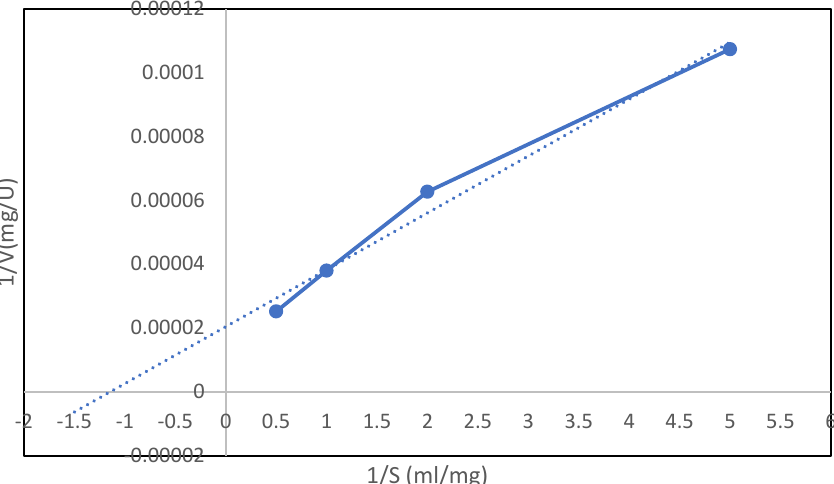
Figure 7. Lineweaver–Burk plot of inulinase from Rhizopus oryzae NRRL 3563.